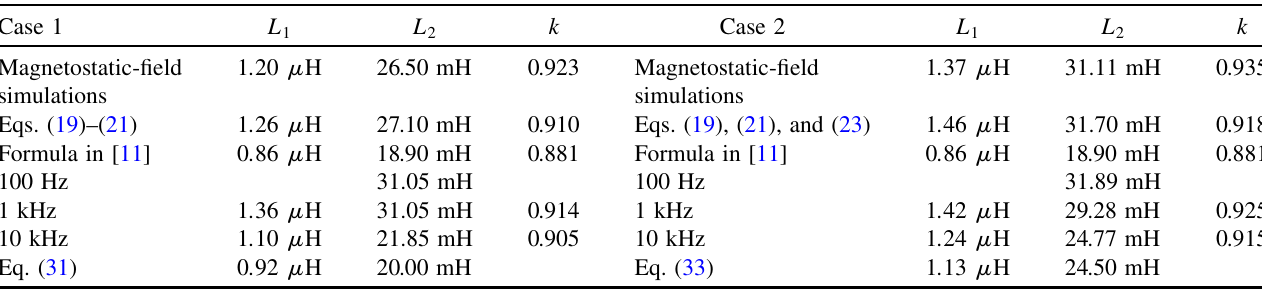
TABLE I. Results of inductance parameters of the pulse transformer with four